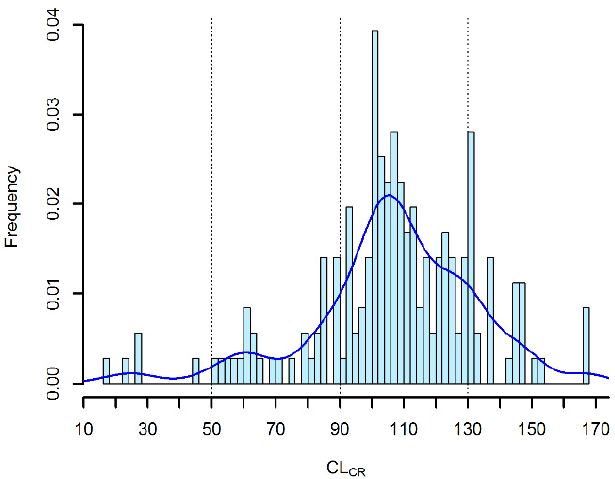
Figure 3. Histogram and kernel density plot of the distribution of patients’ creatinine clearance (CL CR ).